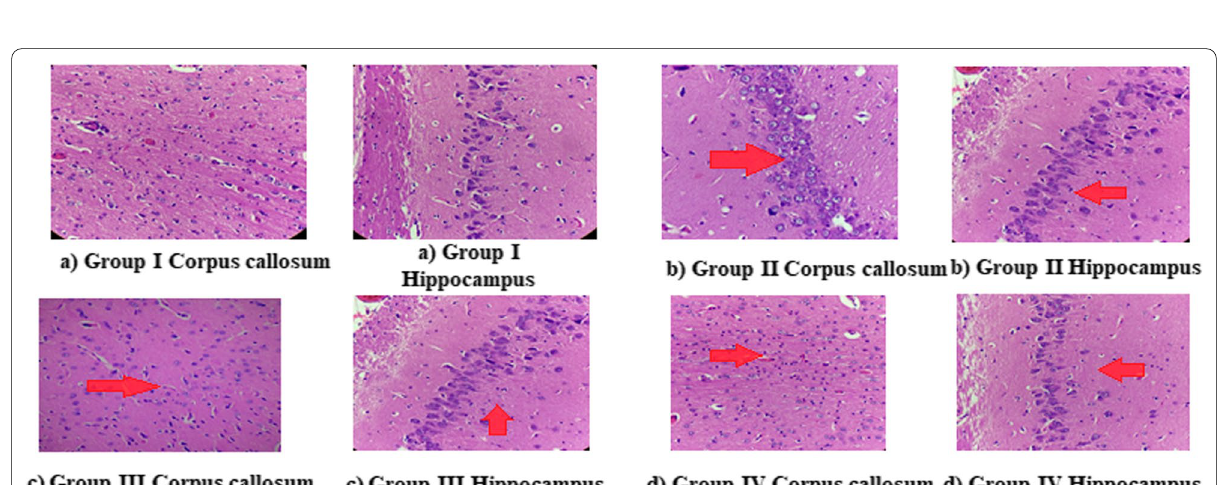
Fig. 9 Representative photomicrographs showing the protective effects of EECT against the neuropathological changes produced by the repeated ICV infusion of PPA. a GROUP I rat brain, b GROUP II rat brain, c GROUP III rat brain, d GROUP IV rat